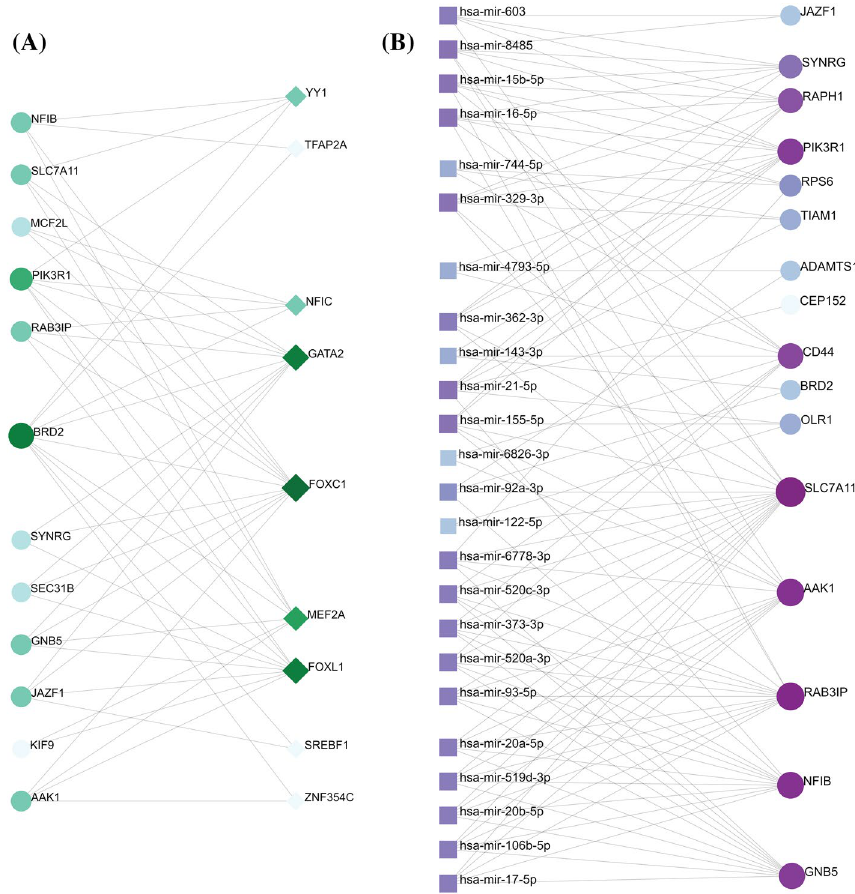
Figure 4. Gene regulatory networks associated with the dysregulated common and hub genes. The figure showing ( A ) gene–TF interacting network and ( B ) gene–miRNA interacting network. The interacting network of miRNAs and TFs were filtered with betweenness centrality ≥ 100 and 45,